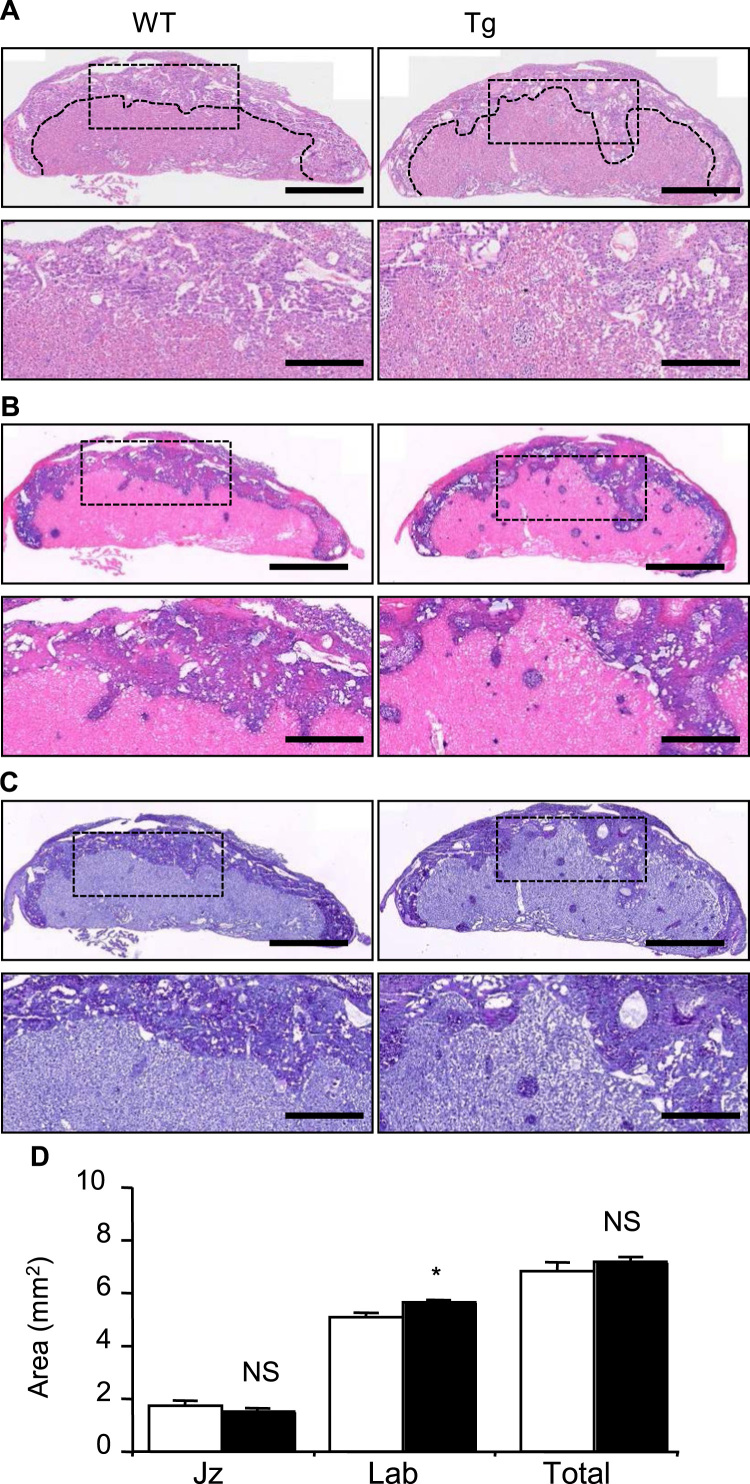
Persistence of junctional zone phenotype at E18.5. (A) H+E staining at E18.5 illustrating loss of the junctional zone. Lower panels are higher magnification of the regions indicated. (B) In situ hybridisation with a Tpbpa riboprobe, which specifically marks the spongiotrophoblast and glycogen cell lineages, at E18.5. Lower panels are higher magnification of the regions indicated. (C) PAS staining for glycogen cells at E18.5. Lower panels are higher magnification of the regions indicated. (D) Midline section areas (mm2) occupied by the junctional zone and labyrinth, and total area of both at E18.5. Scale bars A–C=1000 µm (upper panels); 400 µm (lower panels).